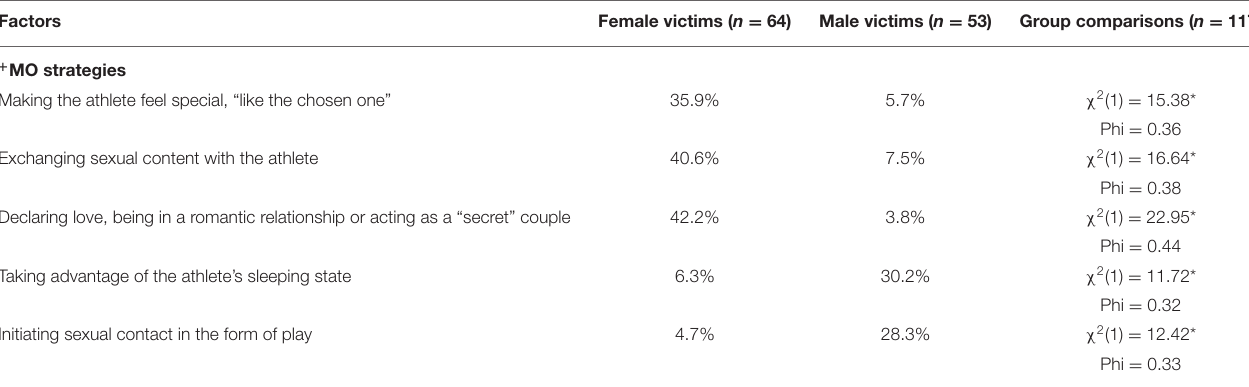
TABLE 3 | Comparison of MO strategies used for male and female